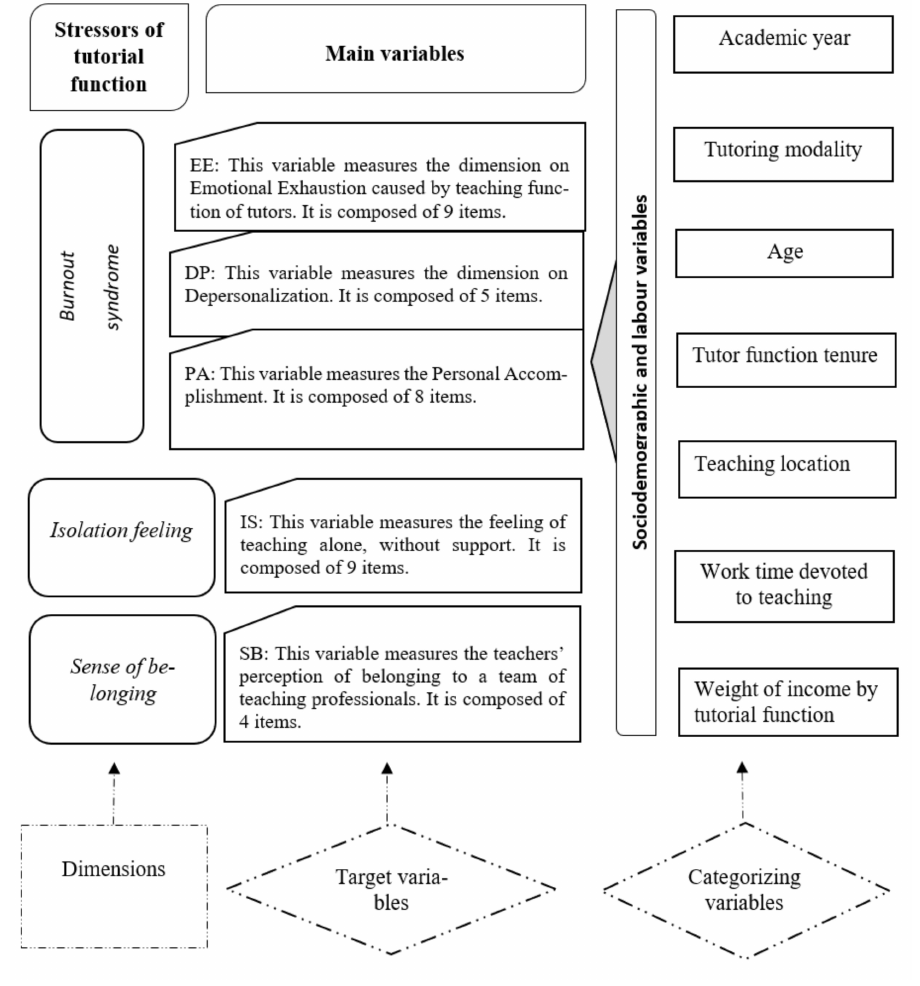
Figure 1. Study design. Source: